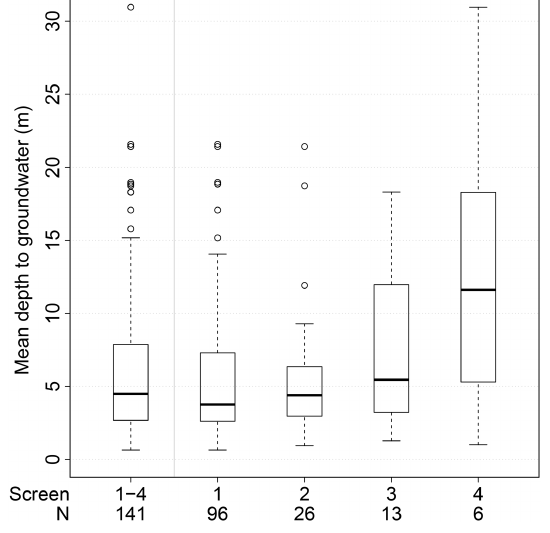
Figure 2. Mean depths to groundwater at the observation wells in metres of the complete set of series and separately for each screen